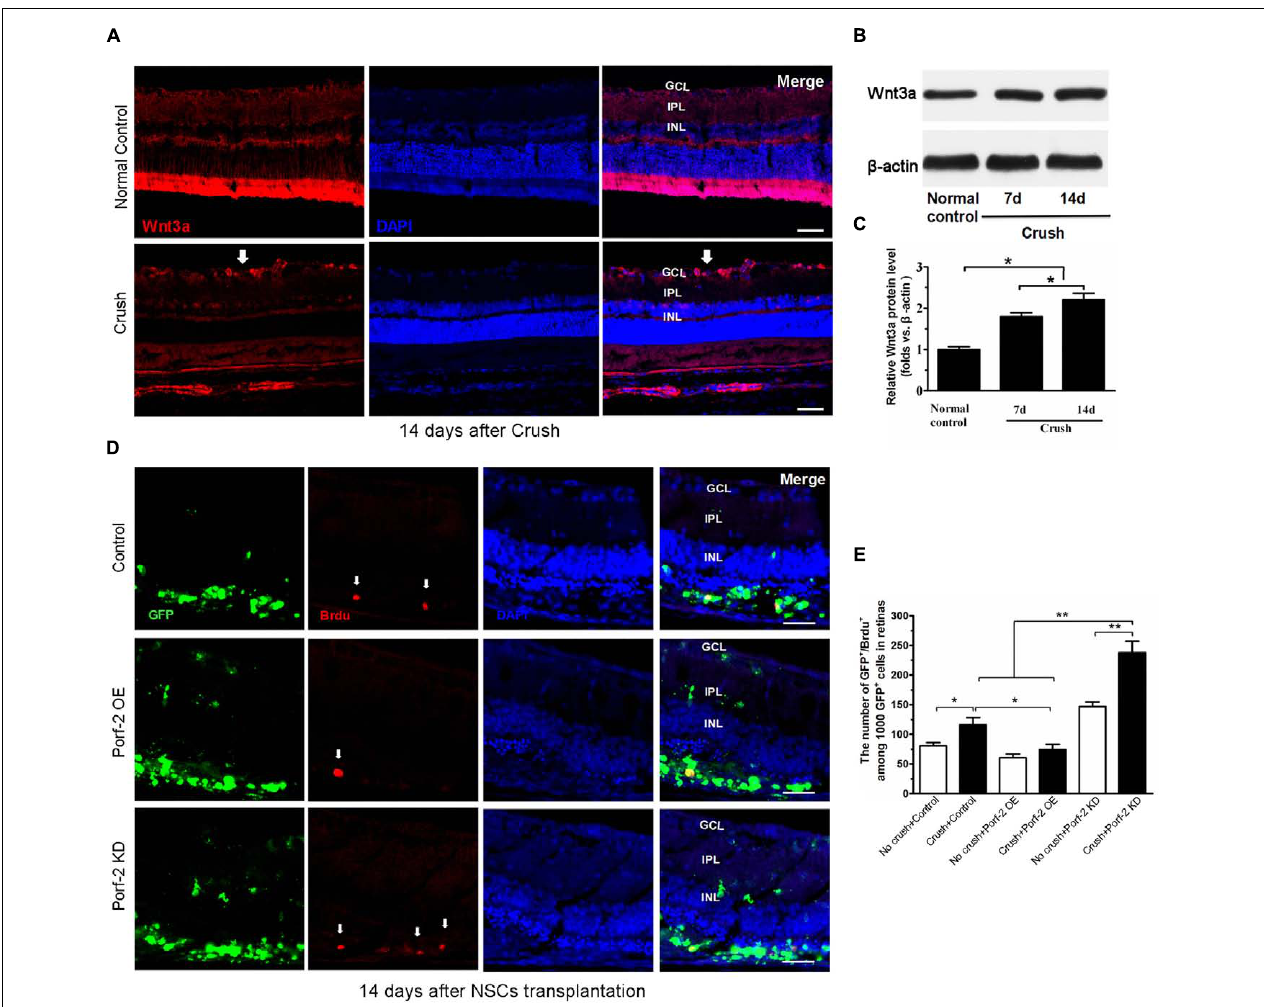
FIGURE 5 | BrdU incorporation and Wnt3a expression after optic nerve injury. (A) The expression of Wnt3a protein in retina after optic nerve injury. Western blot analysis of Wnt3a protein in retina. Scale bars: 50 µ m. Significant changes are shown as p < 0.05, ∗ : vs. the control group. GCL, ganglion cell layer; IPL, inner plexiform layer; INL, inner nuclear layer. Immunofluorescence photomicrographs show the increase of Wnt3a protein in retina after optic nerve injury (white arrow indicated the Wnt3a expression in GCL). (B) Values were normalized to β -actin, used as a loading control. (C) Quantification of relative protein density after normalization with β -actin. (D) Characterization of BrdU-labeled cells at 14 days after transplantation in the control group, in the Porf-2-overexpression group and the Porf-2 knockdown group. White arrow indicates BrdU-positive cells. NSCs were transplanted into the subretinal space immediately after the optic nerve crush. Scale bars: 100 µ m. (E) Comparison of proliferative capacity of control, Porf-2 knockdown NSCs, and Porf-2-overexpression NSCs at 14 days after transplantation ( n = 6 rats). The ratio of each lineage is indicated on the graph. ∗ p < 0.05, ∗∗ p < 0.01. Values are expressed as the mean ± SD ( n = 3